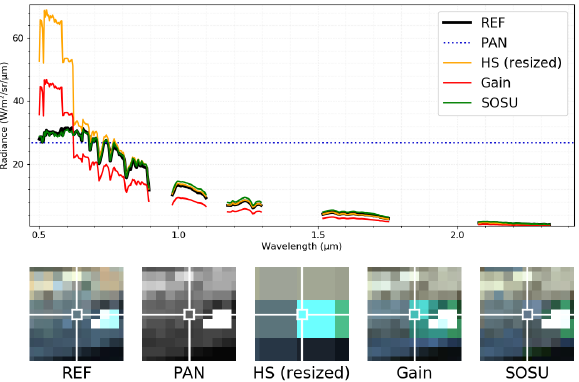
Figure 5. Subpixel better reconstructed with SOSU than